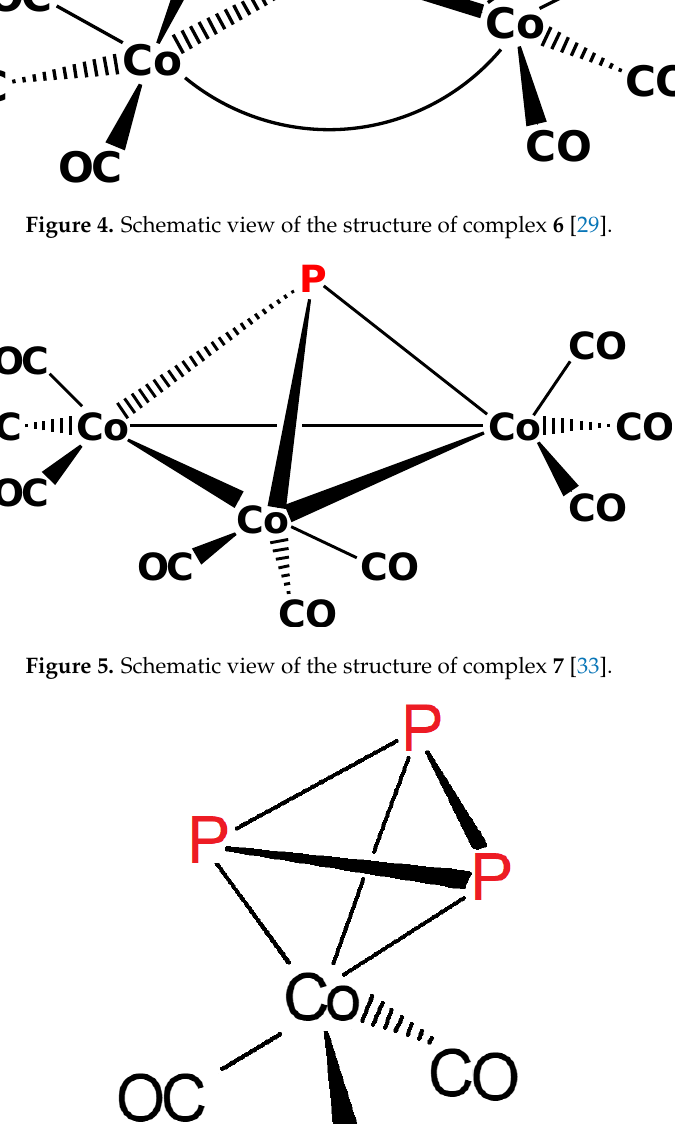
Figure 5. Schematic view of the structure of complex 7 [33].